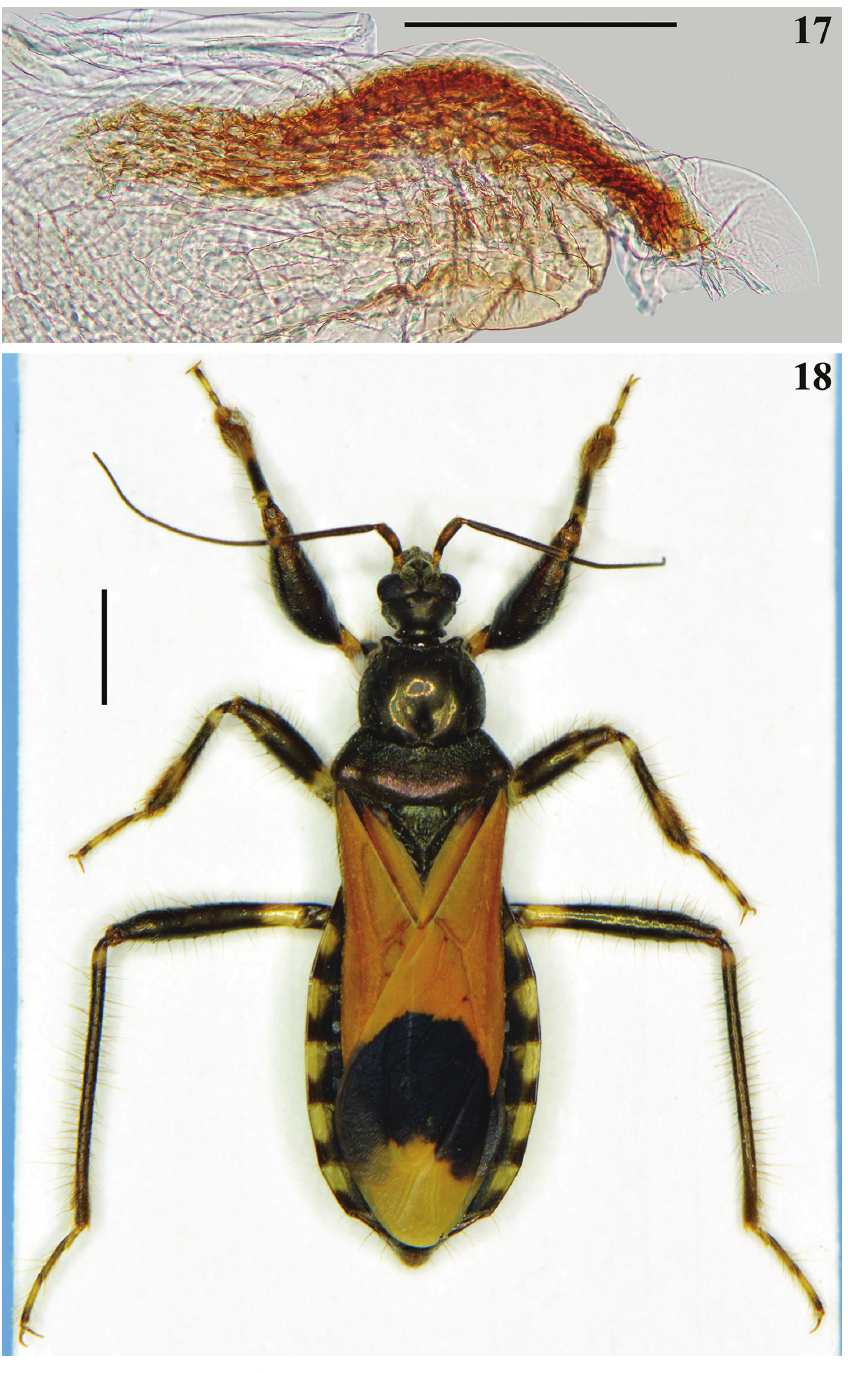
Figures 17–18. Zeraikia novafriburguensis . 17 male genitalia, apical process of endosoma ( ap ) 18 female, dorsal view. Scale bars: 0.3 mm ( 17 ); 2.0 mm ( 18